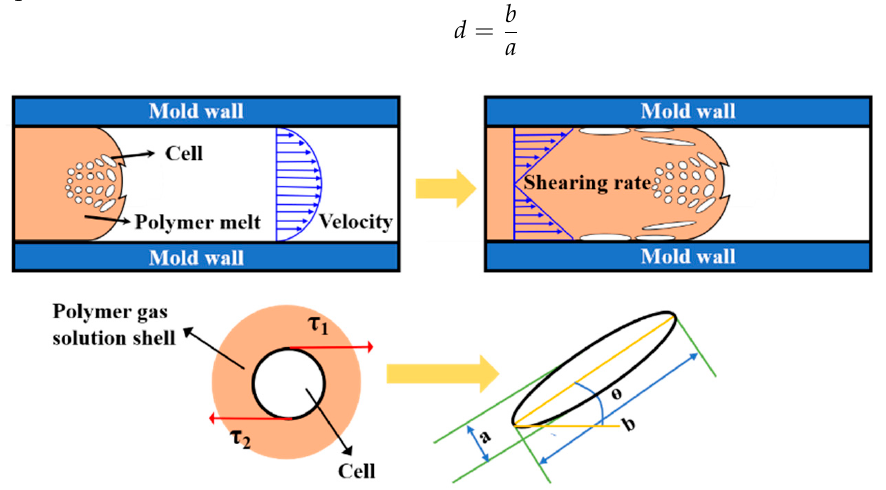
Figure 3. Schematic diagram of the length-diameter ratio and cellular offset angle.